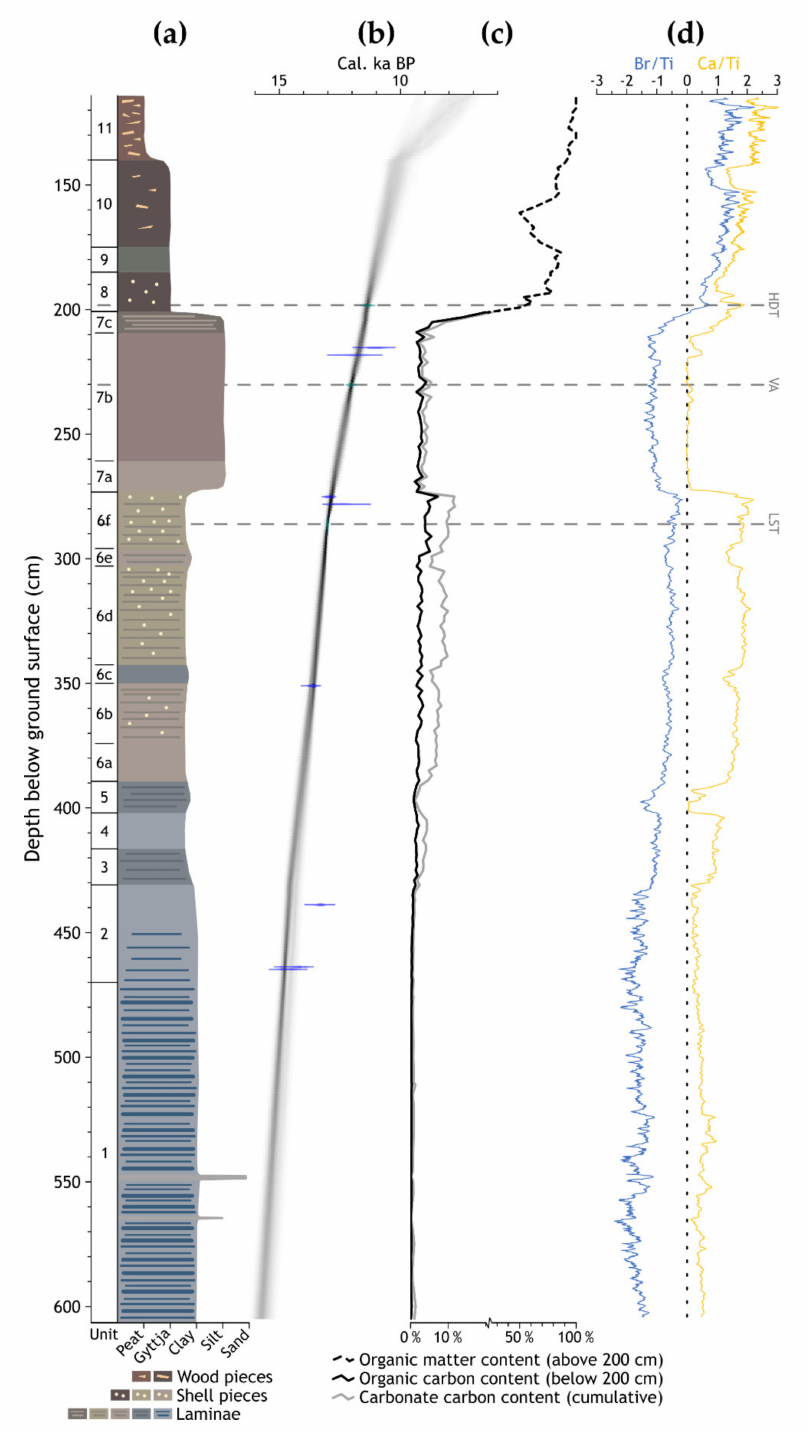
Figure 2. ( a ) Stratigraphy (unit numbers and simplified visualisation with colours resembling those of the sediments), ( b ) age–depth model (with radiocarbon dates indicated by blue error bars), and ( c ) organic matter and carbon contents (NB: broken axis) of the sampled sediment sequence, adapted from the recently published study of the site by Larsson & Wastegård (2022) [55]. ( d ) µ -XRF core- scanning results as selected log-ratio transformed elemental ratios (based on 10-point running means, dotted line shows 0 for reference). The positions of the Hässeldalen Tephra (HDT), the Vedde Ash (VA), and the Laacher See Tephra (LST) are indicated across the graph by dashed grey